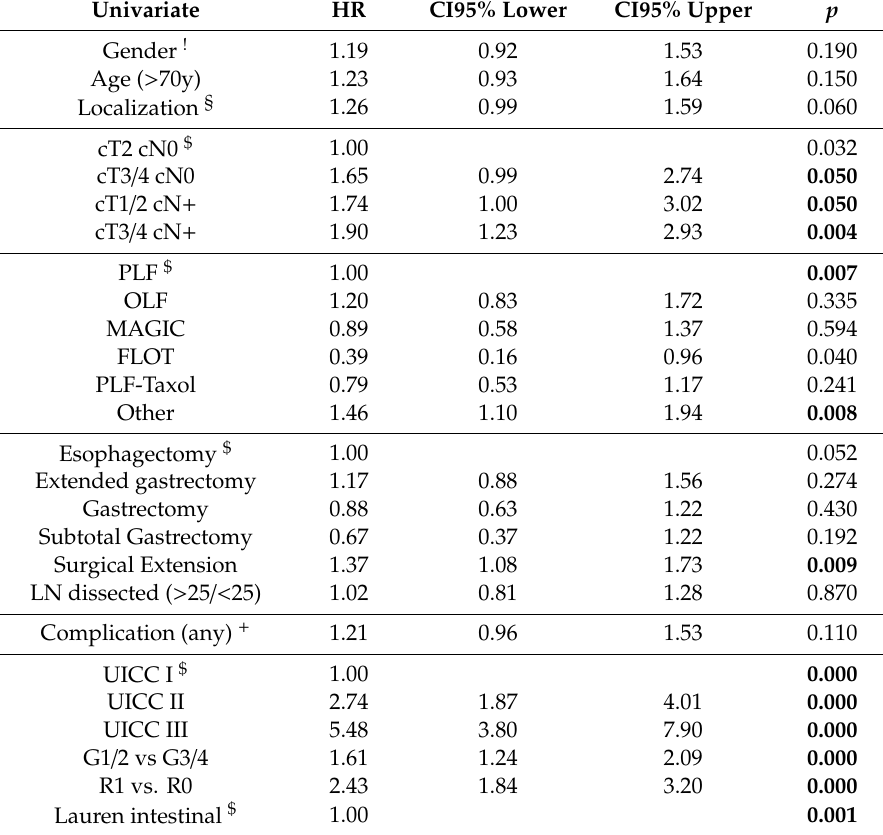
Figure 2. Survival curves according to the Becker grades. The Kaplan-Meier method and the log-rank test were used to compare the estimated survival by each Becker-stage. Table 2. Univariate analysis of predictors for overall